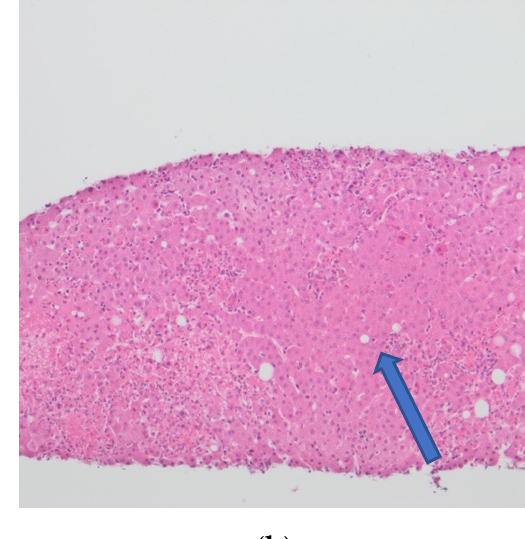
Figure 3. CT scan of the abdomen in frontal plane of case 1 showing an irregular contrasted liver parenchyma 2 days before the patient died. 2.2. Case 2 A 56 year old male patient was diagnosed with a diffuse large B-cell lymphoma (DLBCL). He was treated by six cycles of rituximab, cyclophosphamide, hydroxydauno- rubicin, vincristine, and prednisolone (R-CHOP), followed by two cycles of rituximab. He developed a relapse of a composite lymphoma—histopathological and angioim- munoblastic T-cell lymphoma with an EBV-negative DLBCL. Therapy with rituximab, dexamethasone, cytarabine, and cisplatin (R-DHAP) was initiated (Tables 1 and 2). After the second cycle of R-DHAP, the patient presented in our emergency depart- ment due to fever. Although the patient had no subjective respiratory symptoms, he had a slight need for oxygen via nasal cannula. A CT image showed an atypical pneumonia with bipulmonary, left-accentuated ground-glass opacities. Broad-spectrum antibiotics were initiated. During the inpatient stay, there was an acute increase in initially already elevated transaminases (maximum: SGPT 3194 U/L, SGOT 7459 U/L) (Figure 1b). Bilirubin peaked with 5.2 mg/dL over time. Moreover, the patient had an impaired hemostasis, a mild he- patic encephalopathy (HE), and hypoglycemia. The plasma disappearance rate of indo- cyanine green measured noninvasively by LiMON technology (Pulsion ® Medical Systems; Maquet Getinge Group Munich, Munich, Germany) was in between 2.6%/min and